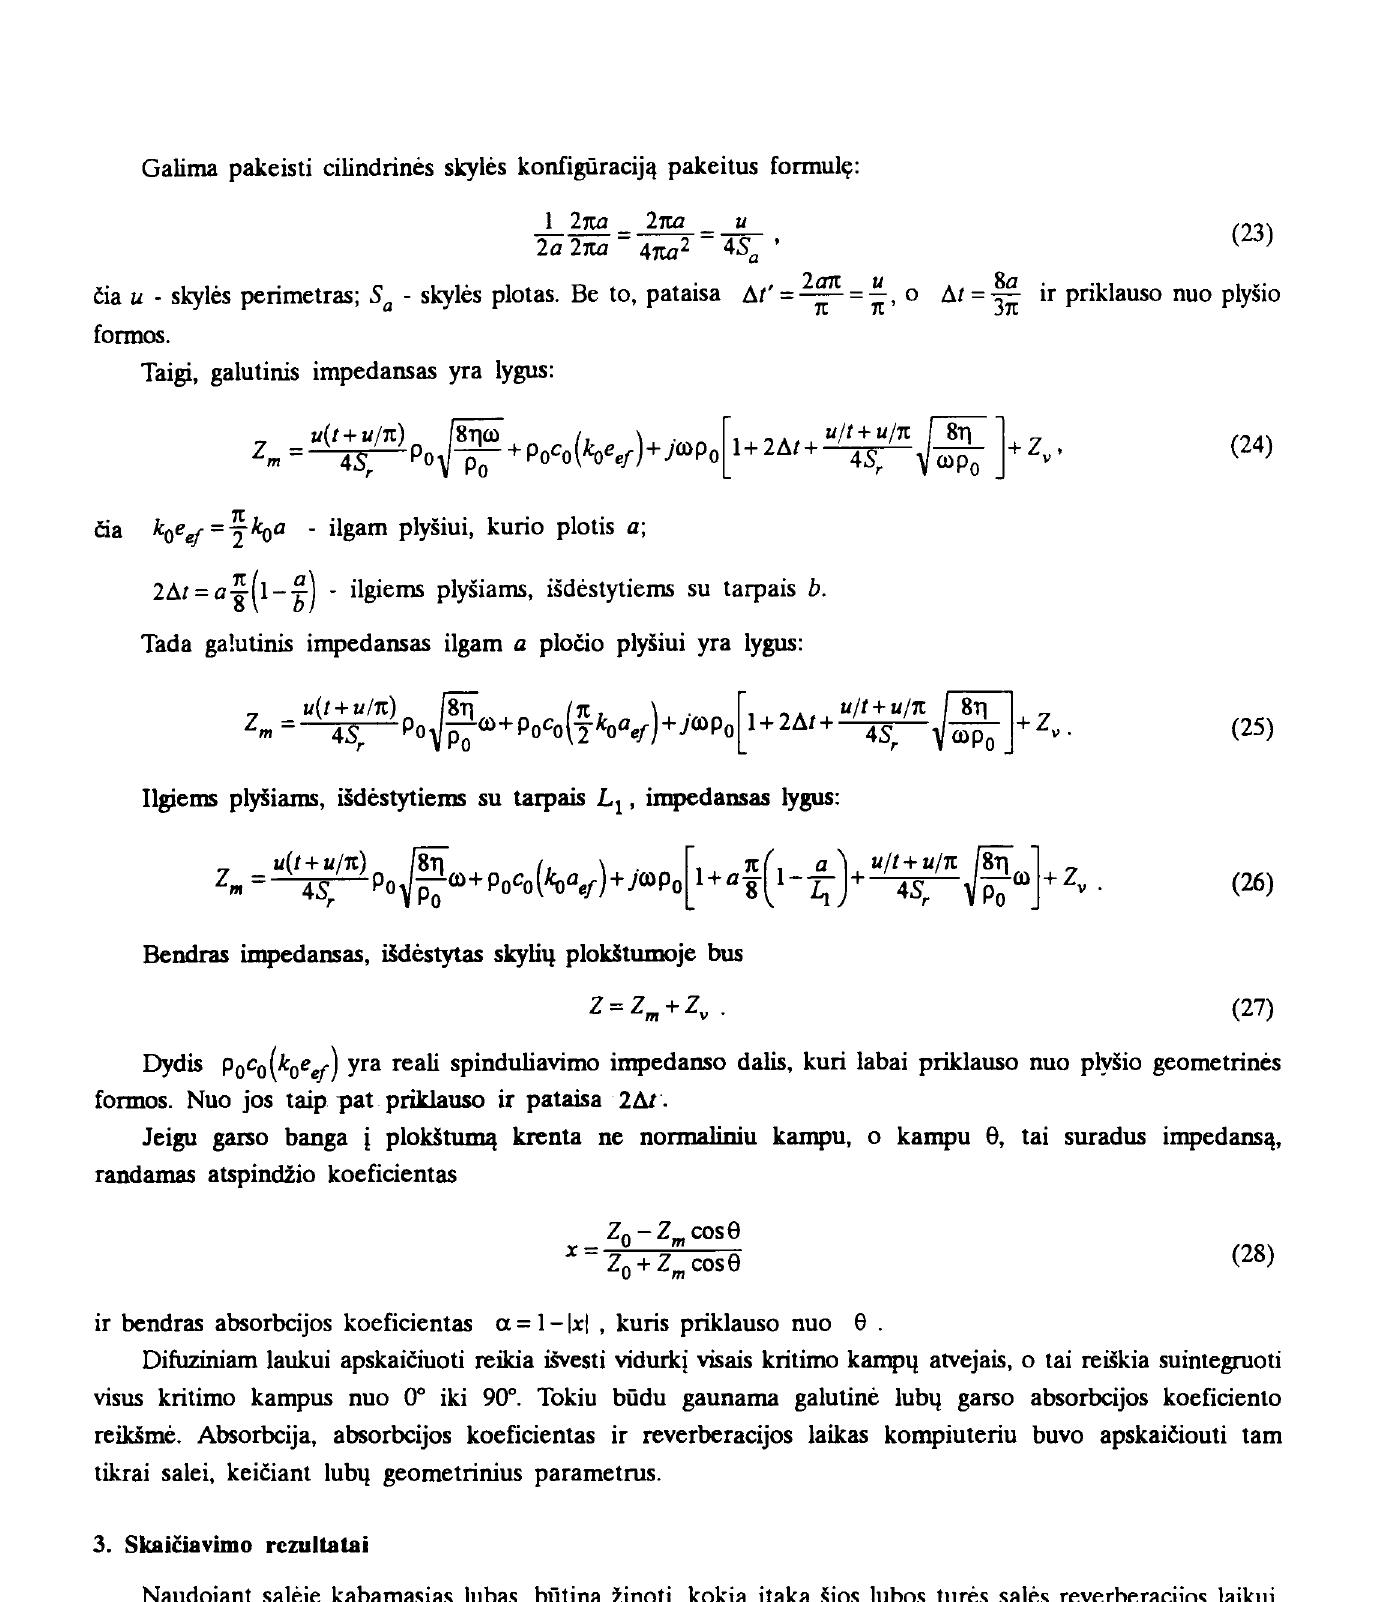
Ilgiems ply5iams, isdestytiems su tarpais L